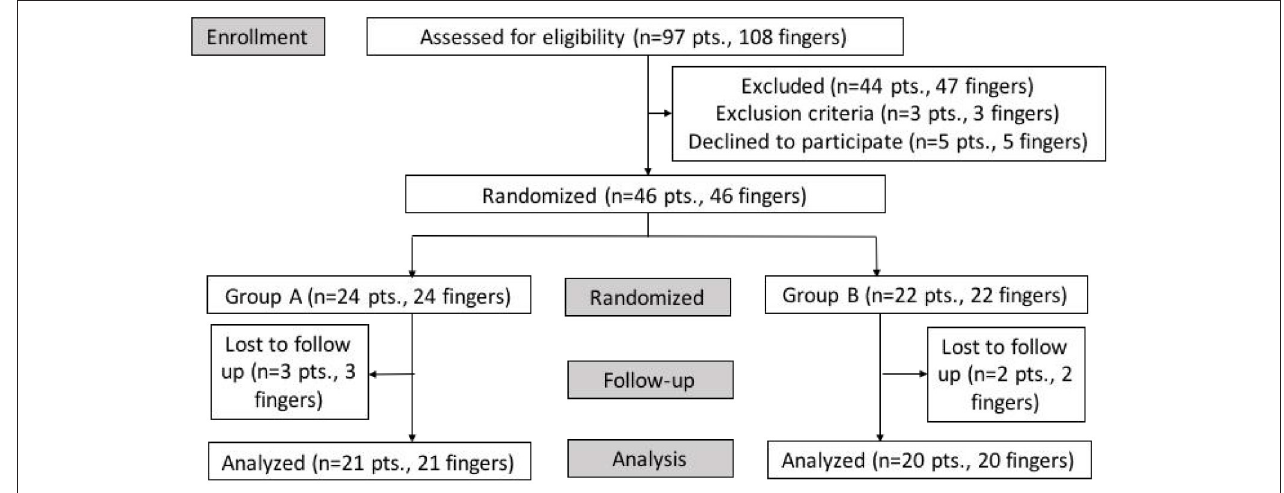
FIGURE 1 | Patients’